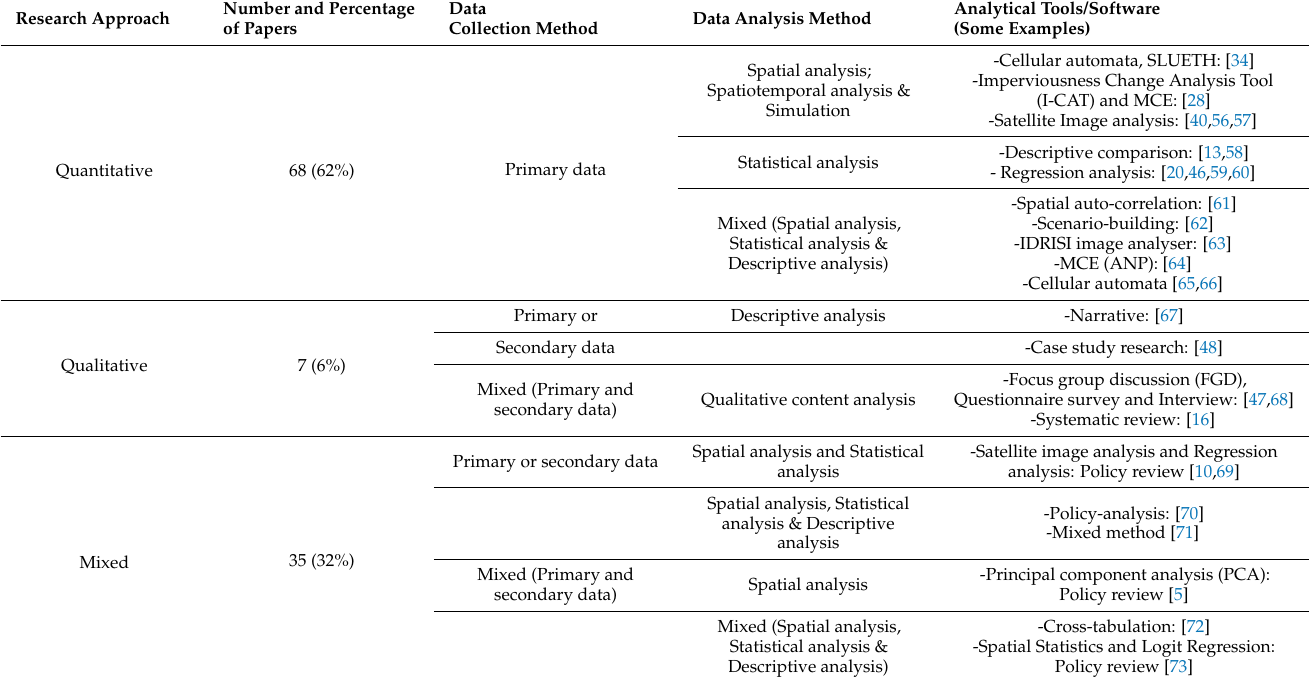
Table 3. Methodological Analysis of Selected Articles in